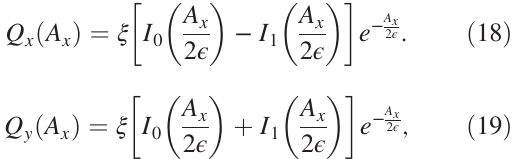
FIG. 1. Beam-beam footprint from free (top) and forced (bottom) oscillations from Eq. (14) and its transformation according to Eq. (9), respectively. The radial oscillation ampli- tude is represented by the color map in units of beam sigma. shows the tune shift versus amplitude for the LHC, with one head-on encounter, ξ ¼ 0 . 0074 , bare machine fractional tunes of Q x ¼ 0 . 31 , Q y ¼ 0 . 32 and driving horizontal tune of 0.292. The forced oscillation is obtained by ramping up an AC dipole in 4000 turns.